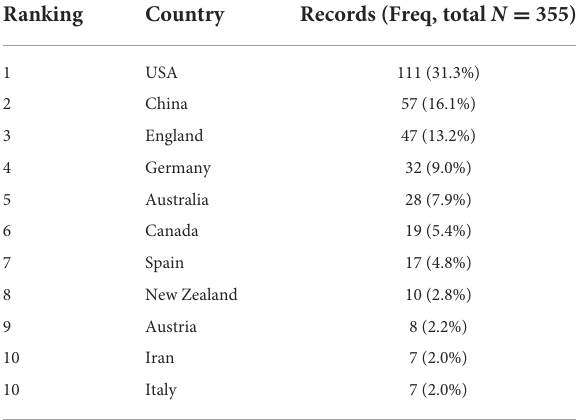
TABLE 1 Top 10 most productive countries for COVID-19 linguistic research. Ranking